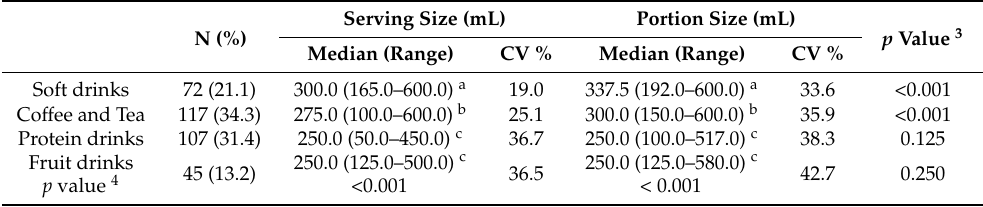
Table 3. Variations in serving size and portion size among different SSBs 1,2 .